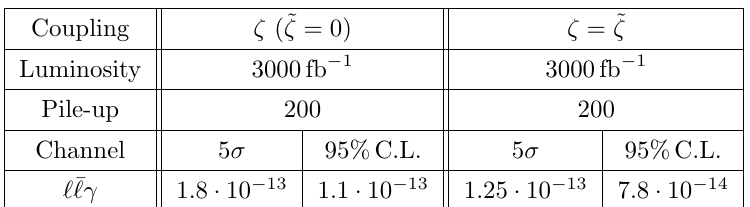
Table 4 . 5 (cid:27) discovery and 95% C.L. exclusion limits on (cid:16) , ~ (cid:16) . Sensitivities are given for 300 fb (cid:0) 1 for (cid:22) = 50 pile-up interactions. The last row corresponds to the search of Z(cid:13) production in both channels with their respective selection cuts.